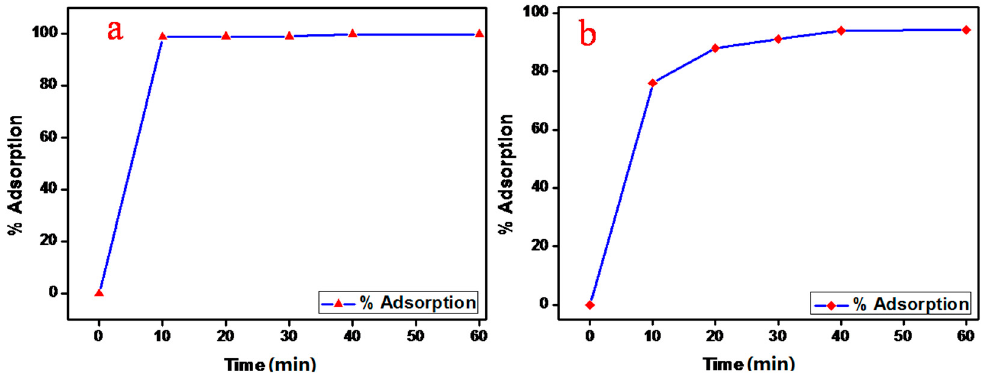
Figure 8. Effect of time on percentage removal of ( a ) MB and ( b ) MO in the presence of GOPSr-2 (initial MB and MO concentration: 20 mg · L − 1 ; amount of adsorbent (MB): 0.5 mg · mL − 1 , (MO): 2 mg · mL − 1 ; pH (MB): 9.5, (MO): 7; at room temperature).